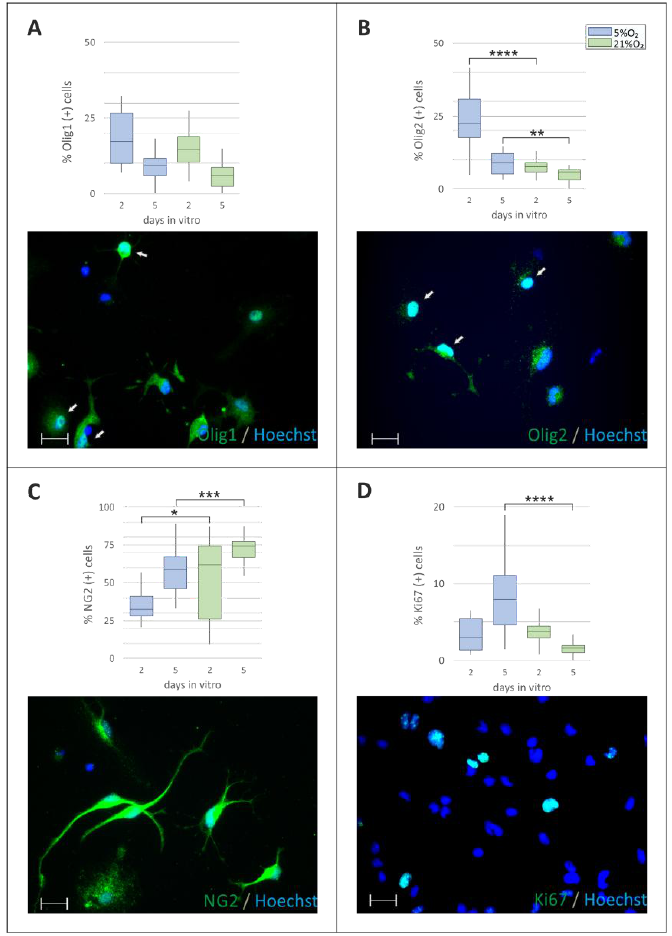
Figure 3. Quantification of immunolabeled oligodendrocyte progenitors in different cell culture conditions. Cell cultures were fixed either after 2 or 5 days in vitro. Blue bars show cells maintained in physiological normoxia (5% O 2 ) and green bars represent cells kept at the standard oxygen level (21% O 2 ). ( A ) Expression of the lineage-specific transcription factor Olig1 ( green ), which is detected in the cell cytoplasm on the 2nd DIV (white arrows) and gradually decreases during cell maturation; ( B ) Expression of the transcription factor Olig2 ( green ), which is relevant for the early stages of oligodendrocyte differentiation (white arrows); ( C ) Progenitor cells recognized by the presence on their surface of the NG2 marker; ( D ) Proliferating cells characterized by the presence of the Ki67 marker in the cell nuclei. The cell nuclei were visualized with Hoechst 33258 solution ( blue ). The scale bar is equivalent to 20 µm. The calculated differences were marked as the significant if: * p < 0.05, ** p < 0.01; *** p < 0.001, **** p < 0.0001.